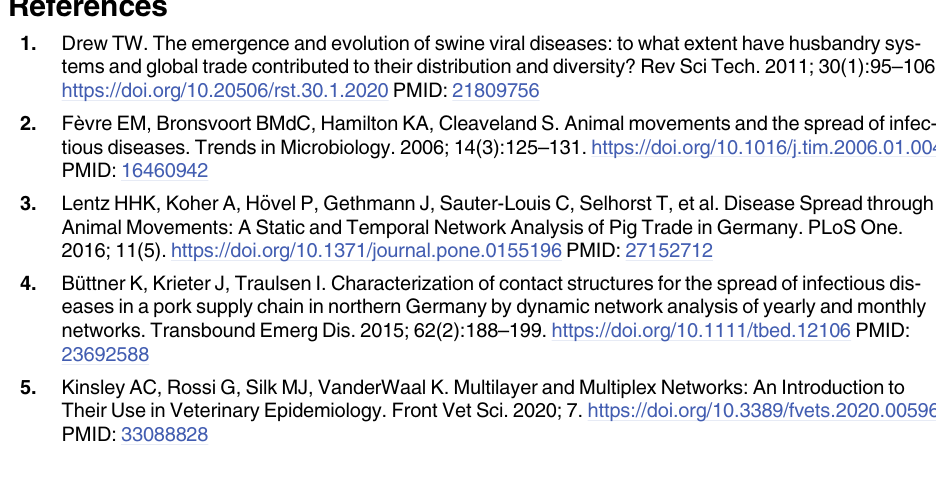
S18 Table. Annual time-series of centralities for the growing pigs